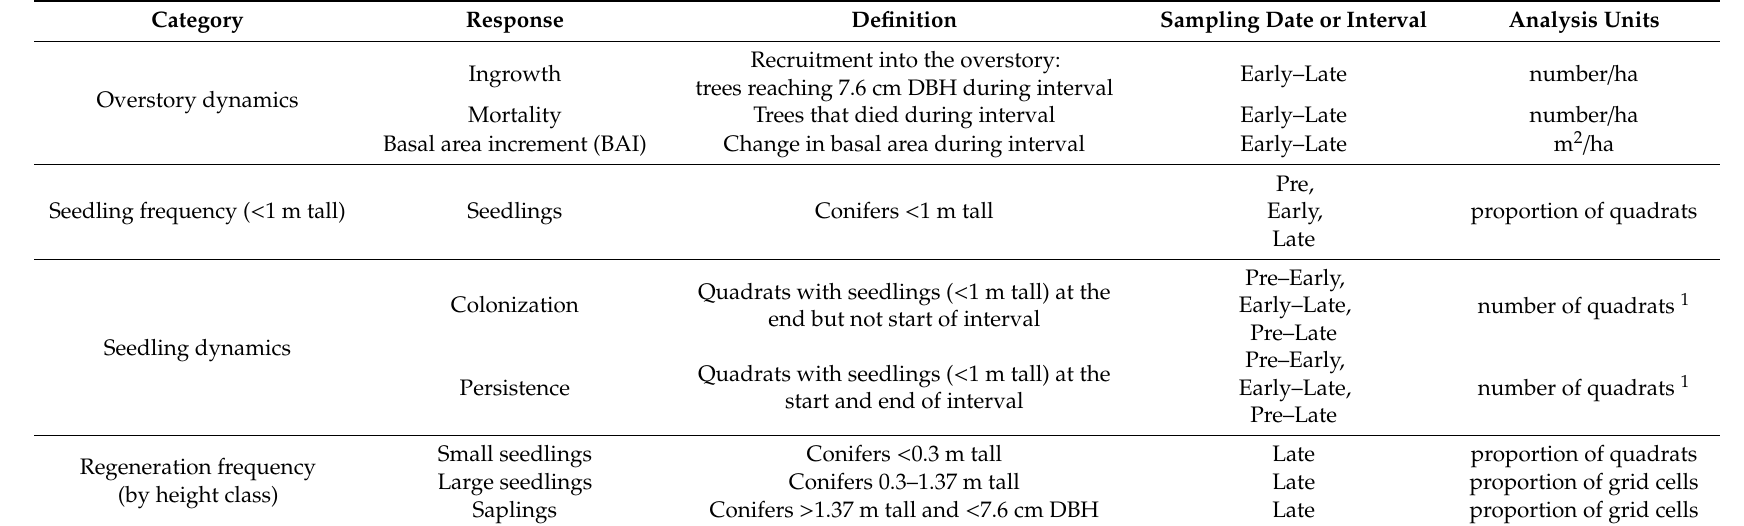
Table 1. Details of response variables used to assess relationships with overstory structure, fuels treatments, and wildfire. All responses were analyzed at the plot